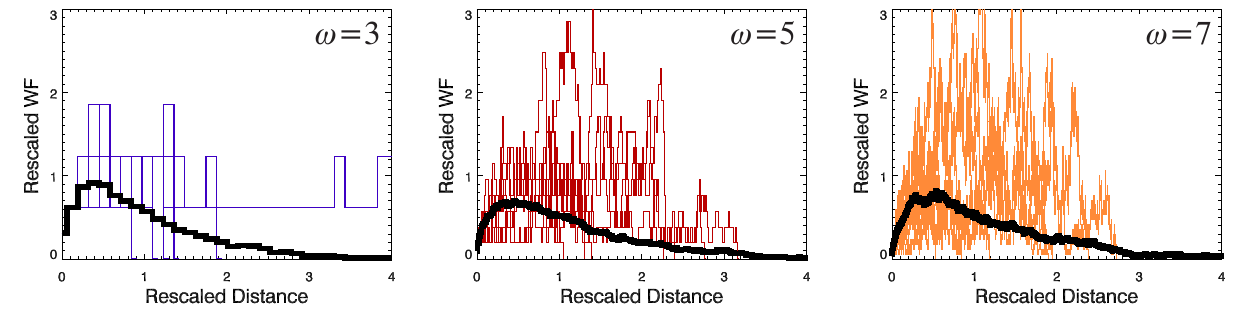
Fig. 3. Width functions, W ω (x) and average width function E [ W ω (x) ] (solid black line) for RSN with different order ω , and parameters p i = 0 . 36 and p e = 0 . 48. The vertical axis (number of links at distance x from the outlet) has been rescaled by the factor (R C /R A ) ω − 1 and the horizontal axis (distance from the outlet x ) has been rescaled by the factor R ω − 1 respectively.